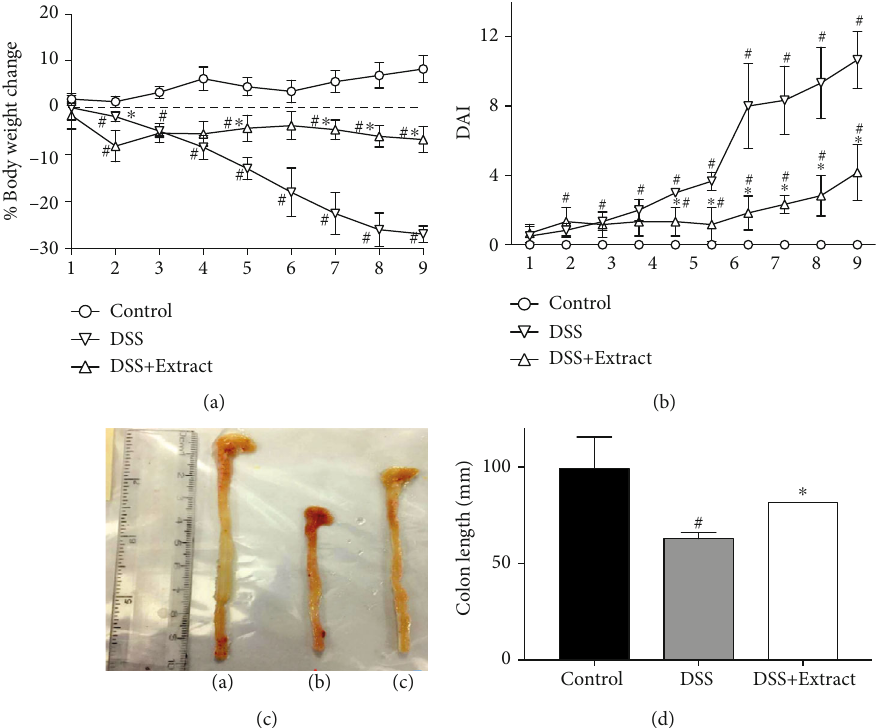
Figure 2: E ff ect of the methanolic extract of C. procera in DSS-induced colitis. (a) % body weight change compared with the initial body weight. (b) Disease activity index, considered as the summary of the % body weight loss, bleeding and diarrhea. (c) Gross picture of colons in the following groups: a) Control, b) DSS, and c) DSS+Extract. (d) Variations in colon length. Data presented are the mean values from all three groups ( n = 6 ) ∗ P < 0 : 001 vs DSS group, # P < 0 : 001 vs Control group.